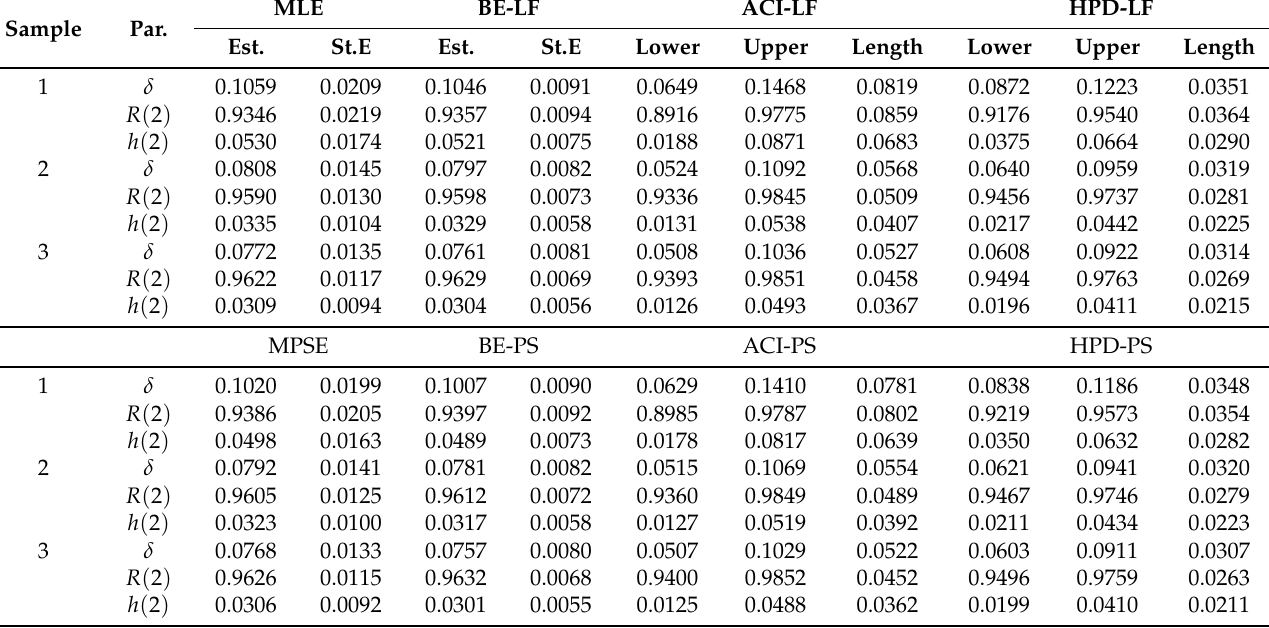
Table 4. Point and interval estimates of δ , R ( t ) , and h ( t ) from mechanical equipment data.